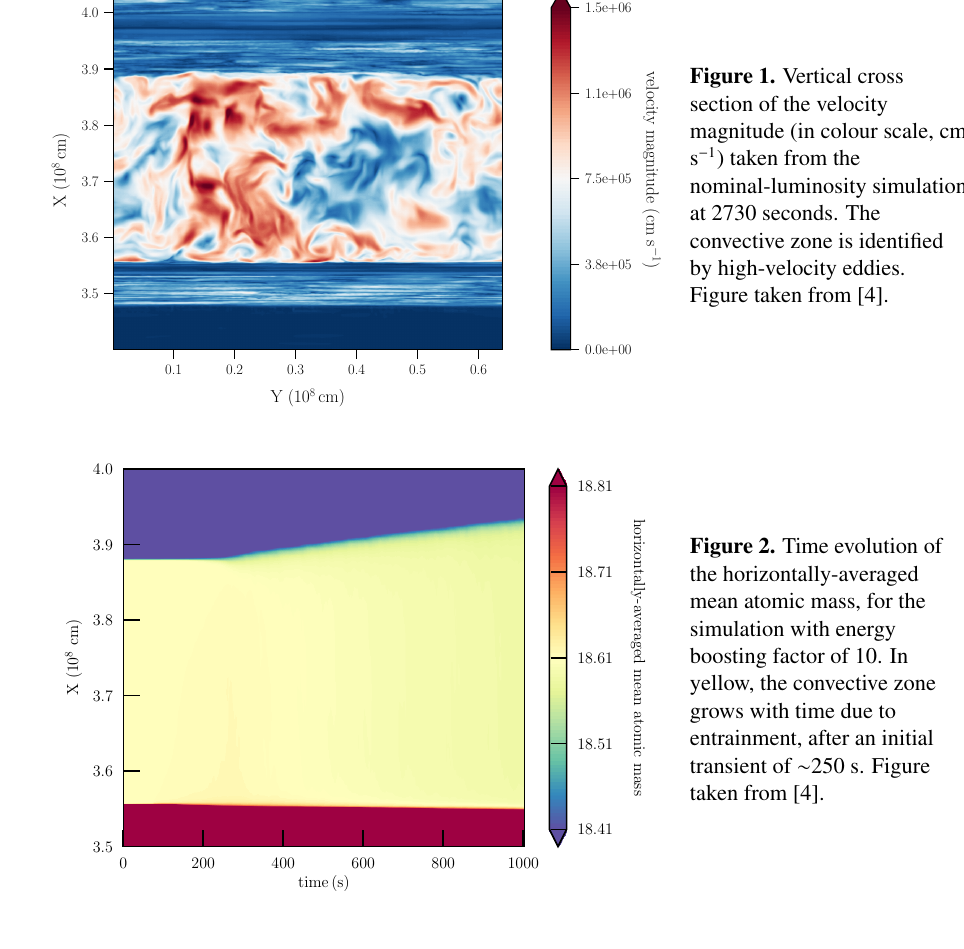
Figure 1. Vertical cross section of the velocity magnitude (in colour scale, cm s − 1 ) taken from the nominal-luminosity simulation at 2730 seconds. The convective zone is identified by high-velocity eddies. Figure taken from [4].